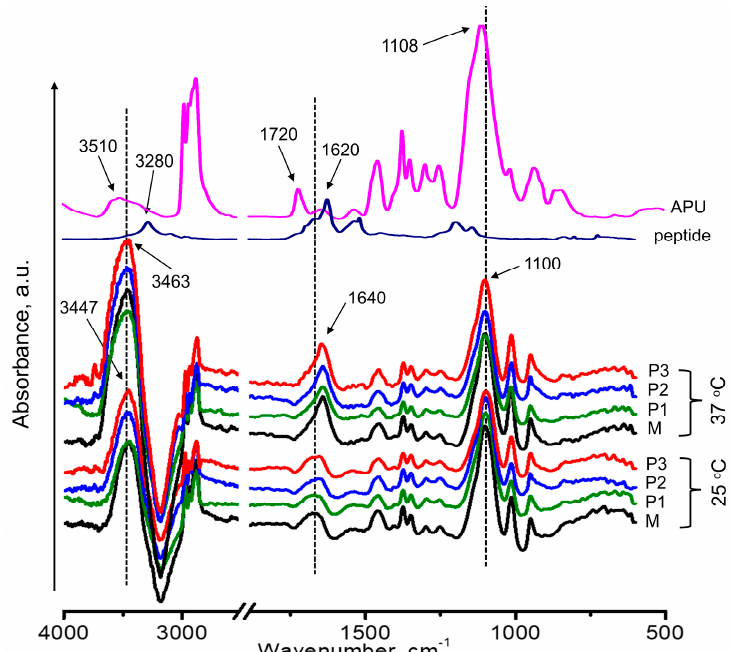
Figure 4. ATR-FTIR spectra of solutions (25 °C) and gels (37 °C) for the investigated samples compared with raw APU and peptide spectra.